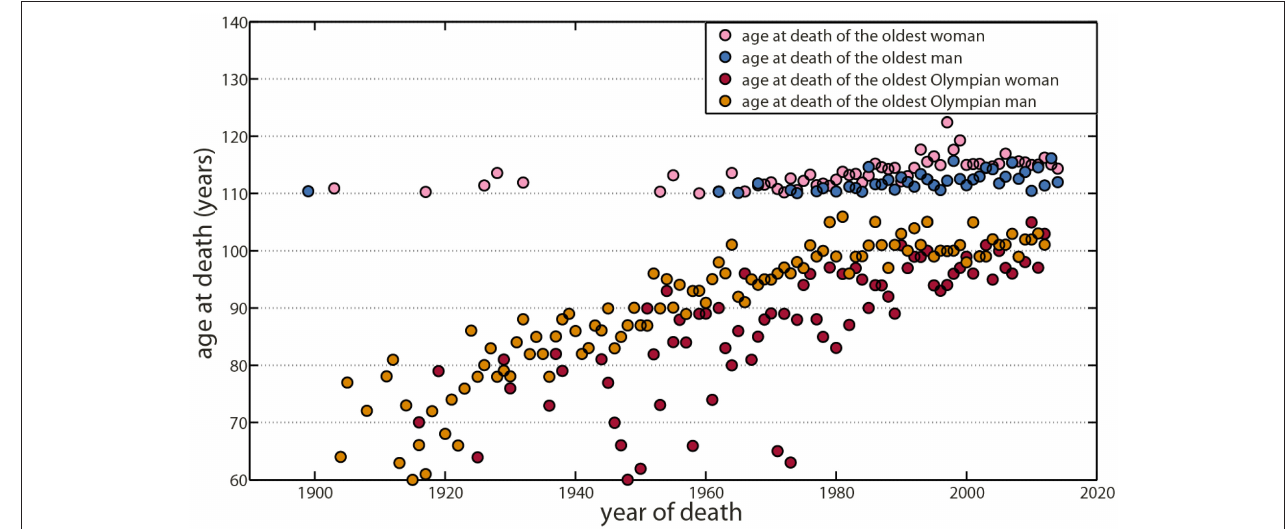
FIGURE 2 | Maximal lifespan trends have shown a plateau for the oldest supercentenarian and the oldest Olympian. Since Jeanne Calment, who currently holds the lifespan record at 122.4 years in 1997, no one has lived more than 120 years and data suggest a plateau around 115–117 years that may indicate the potential biological upper limit of our species in terms of longevity. Oldest supercentenarian trends have shown a plateau for both women (purple) and men (blue). Similarly, maximal lifespan trends for oldest Olympians have shown a plateau for both women (red) and men (orange). Data for supercentenarians are available at the Gerontological Research Group (GRG; http://www.grg.org/). Data for Olympian athletes came from the most authoritative source of Olympian biographies (Clarke et al., 2012; Antero-Jacquemin et al., 2015